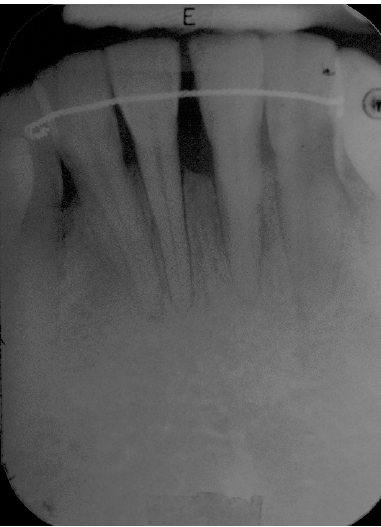
Figure 9. Six-months post-operative radiograph, improved bone support, especially around the central left incisor can already be appreciated.